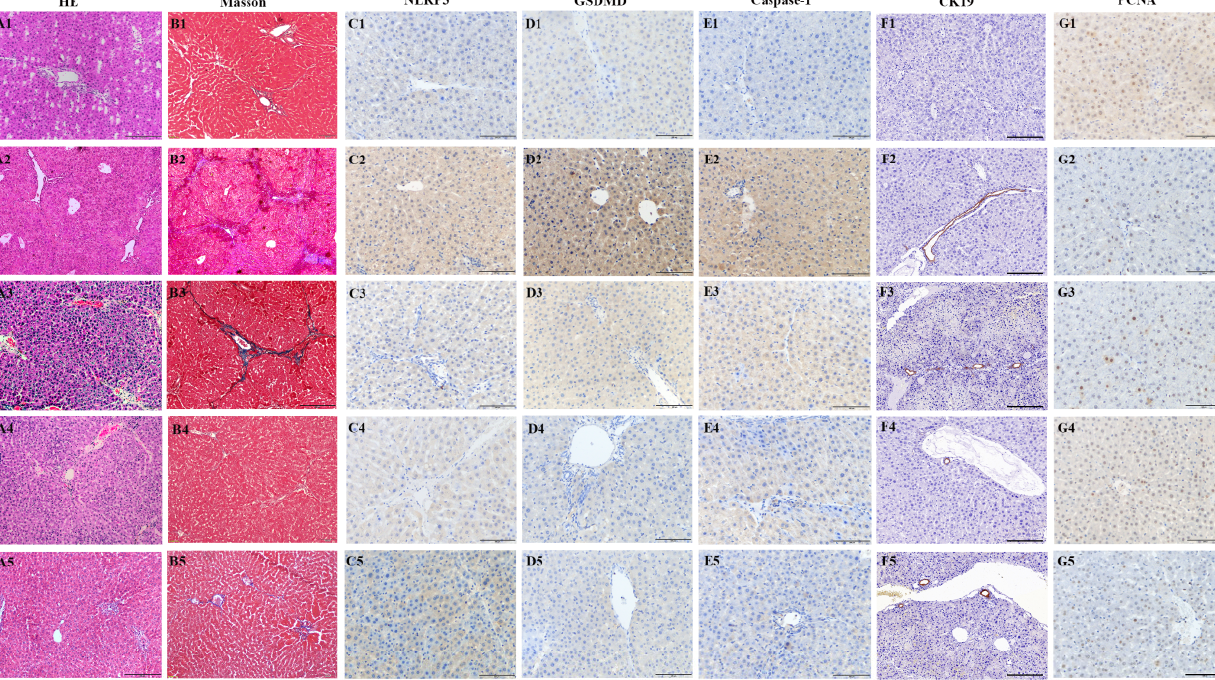
Figure 5. The therapeutic effect of Exo-BMMSC on liver cirrhosis was assessed in pathological sec- tions and by measuring liver function. HE-stained sections from the control, liver cirrhosis and ex- osome treated groups are shown ( A ). Masson-stained sections from the different treatment groups are shown ( B ). Semi-quantitative analysis of the collagen-positive area showed that the areas in the medium dose and the high dose Exos-rBMMSC groups were significantly decreased compared with those in the liver cirrhosis group (( M ), ** p < 0.01). The collagen area in the medium dose Exos group was significantly lower than that in the low dose Exos group but was higher than that in the high dose Exos group (( M ), # p < 0.05). NLRP3-, GSDMD-, caspase-1-, CK19- and PCNA-positive cells were assessed by immunohistochemistry ( C – G ). Semi-quantitative analysis showed that NLRP3-, GSDMD-, caspase-1- and PCNA- positive cells in all the Exos treatment groups were significantly lower than those in the liver cirrhosis group (( G – K ), ** p < 0.01). The CK19-positive cells in the low dose Exo group had no significant significance compared to the liver cirrhosis (( K ), p > 0.05). The NLRP3-positive cells and the CK19- positive cells in the medium dose Exos group were not signifi- cantly different from those in the low dose and the high dose Exos groups ( H , K ). The numbers of GSDMD- and caspase-1-positive cells in the medium dose Exos group were dramatically lower than those in the low dose Exos group but were higher than those in the high dose Exos group (( I , J ), # p < 0.05). The numbers of PCNA- positive cells in the medium dose Exos group were significantly